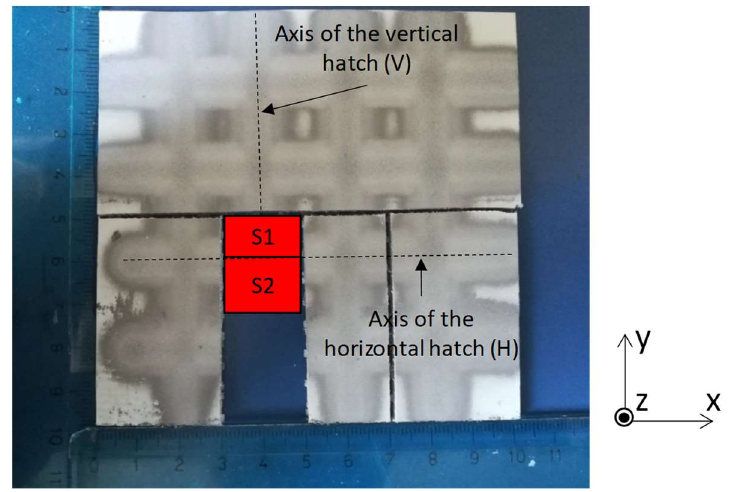
Figure 2. Extraction from the sprayed panel of the samples S1 and S2 , for the SEM measurements.